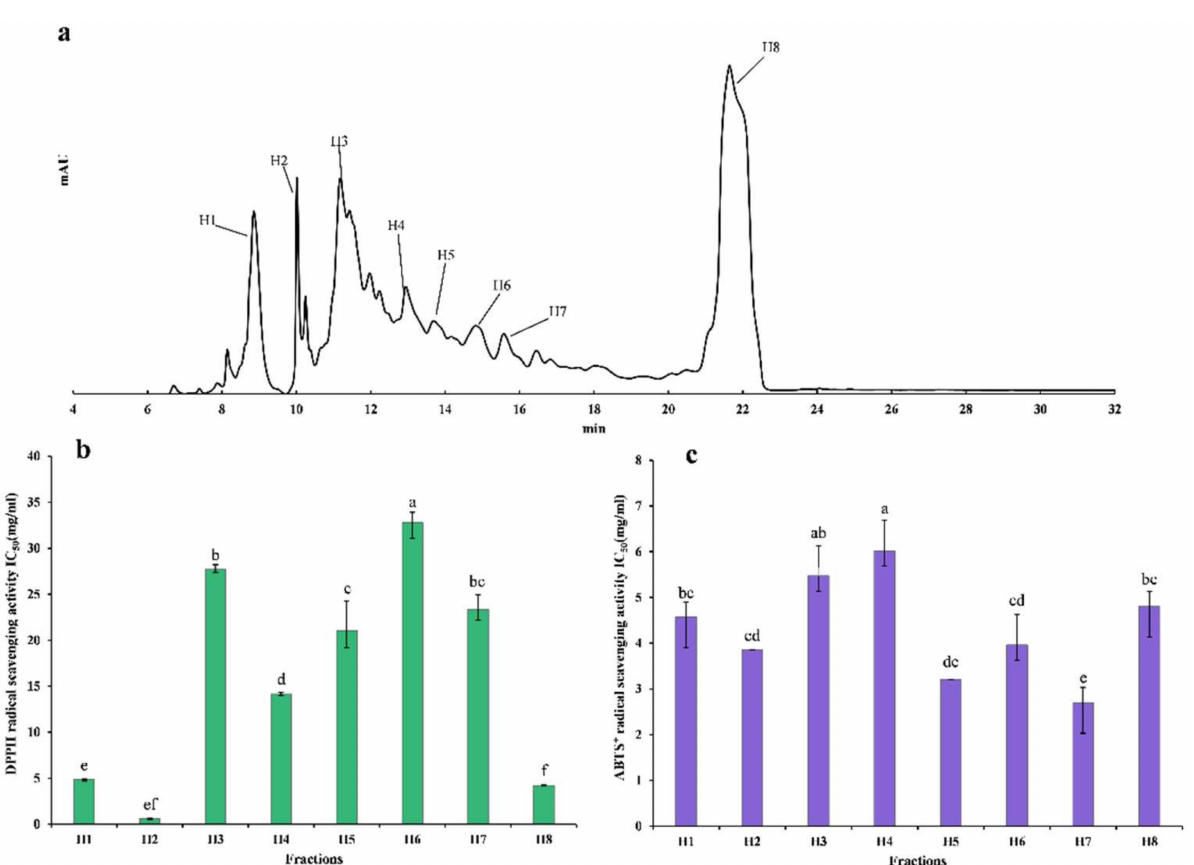
Figure 1. ( a ) RP-HPLC of the active fraction M4 that was obtained from ultrafiltration; ( b ) DPPH radical scavenging activity IC 50 (mg/mL) of fractions obtained by RP-HPLC; ( c ) ABTS radical scavenging activity IC 50 (mg/mL) of the fractions obtained by RP-HPLC. Different letters (a–f) in the same test indicate significant differences ( p <